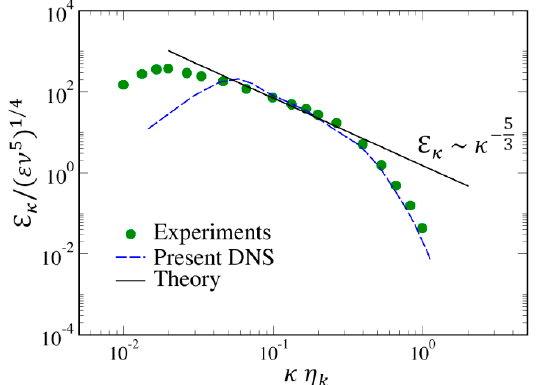
Figure 1. Non-dimensional three-dimensional (3D) energy spectrum ε κ of the turbulent flow field of the present DNS. Experimental points correspond to Comte-Bellot and Corrsin [41] and the black solid line indicates the − 5 / 3 scaling.